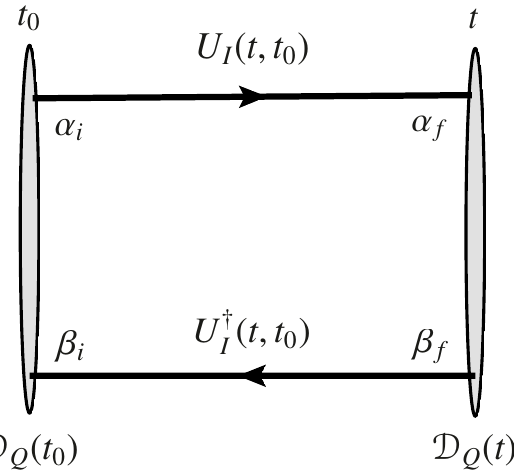
Figure 2 . Graphical representation of the evolution of the density matrix from t 0 to t . The hori- zontal lines represent the evolution operators U I ( t; t 0 ) (upper branch) or U y When D Q is the density matrix of a single heavy quark, these horizontal lines may be interpreted as the associated propagators of the heavy particle. When D Q is the density matrix of a heavy quark-antiquark pair, a single horizontal line is replaced by a pair of lines, associated with the propagator of the pair (see (cid:12)gure 6 below).